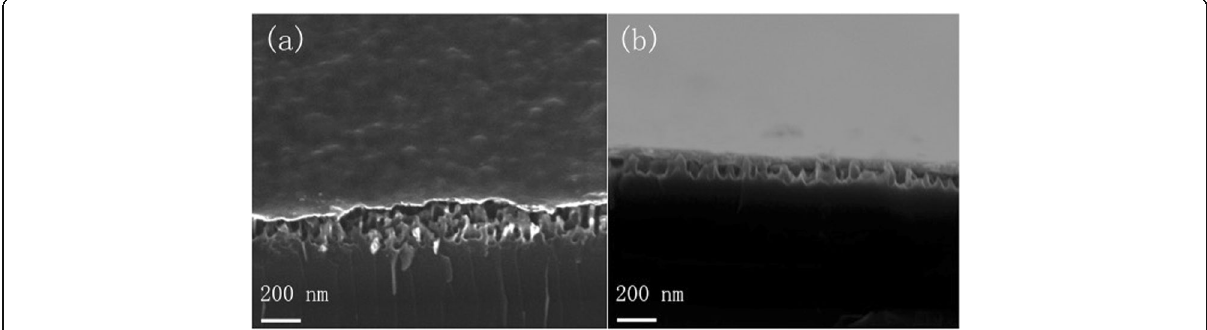
Fig. 5 The SEM images of PEDOT:PSS on nanostructured Si substrates: a the substrates without TMAH treatment and b the substrates with TMAH treatment (60